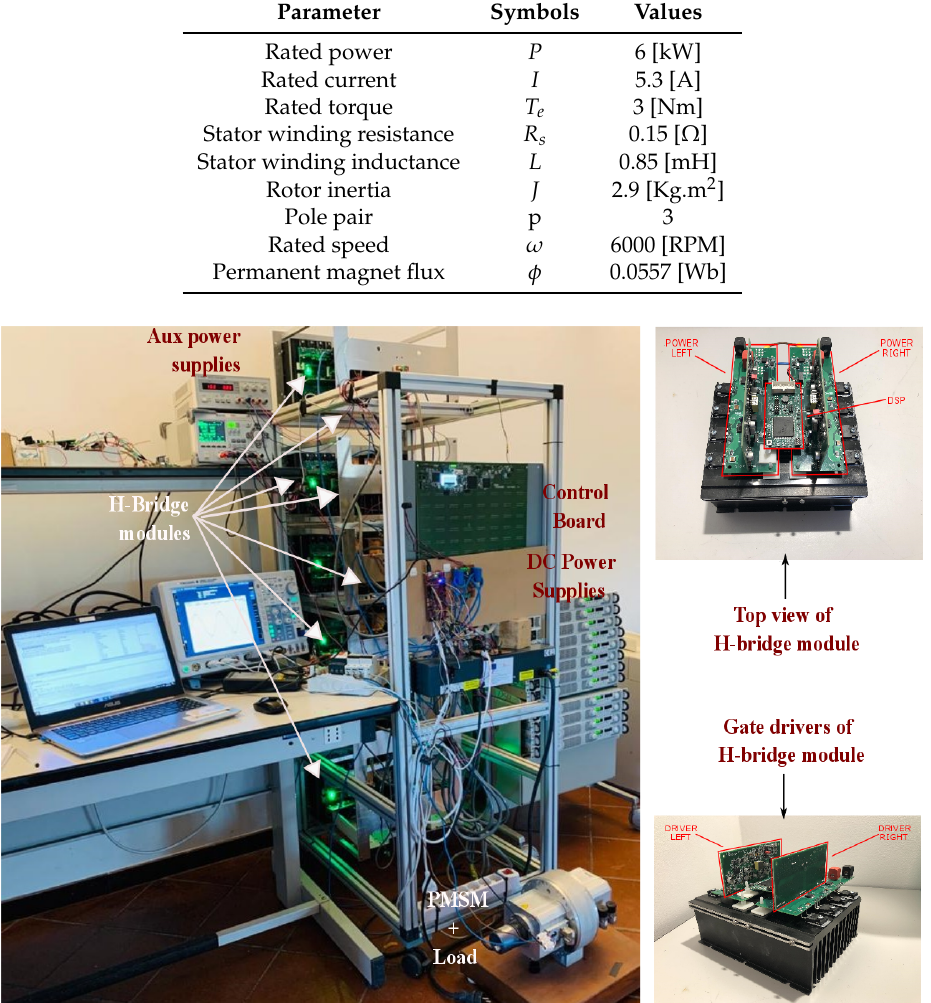
Figure 16. Test rig of cascaded H-bridge (CHB) 9-level inverter